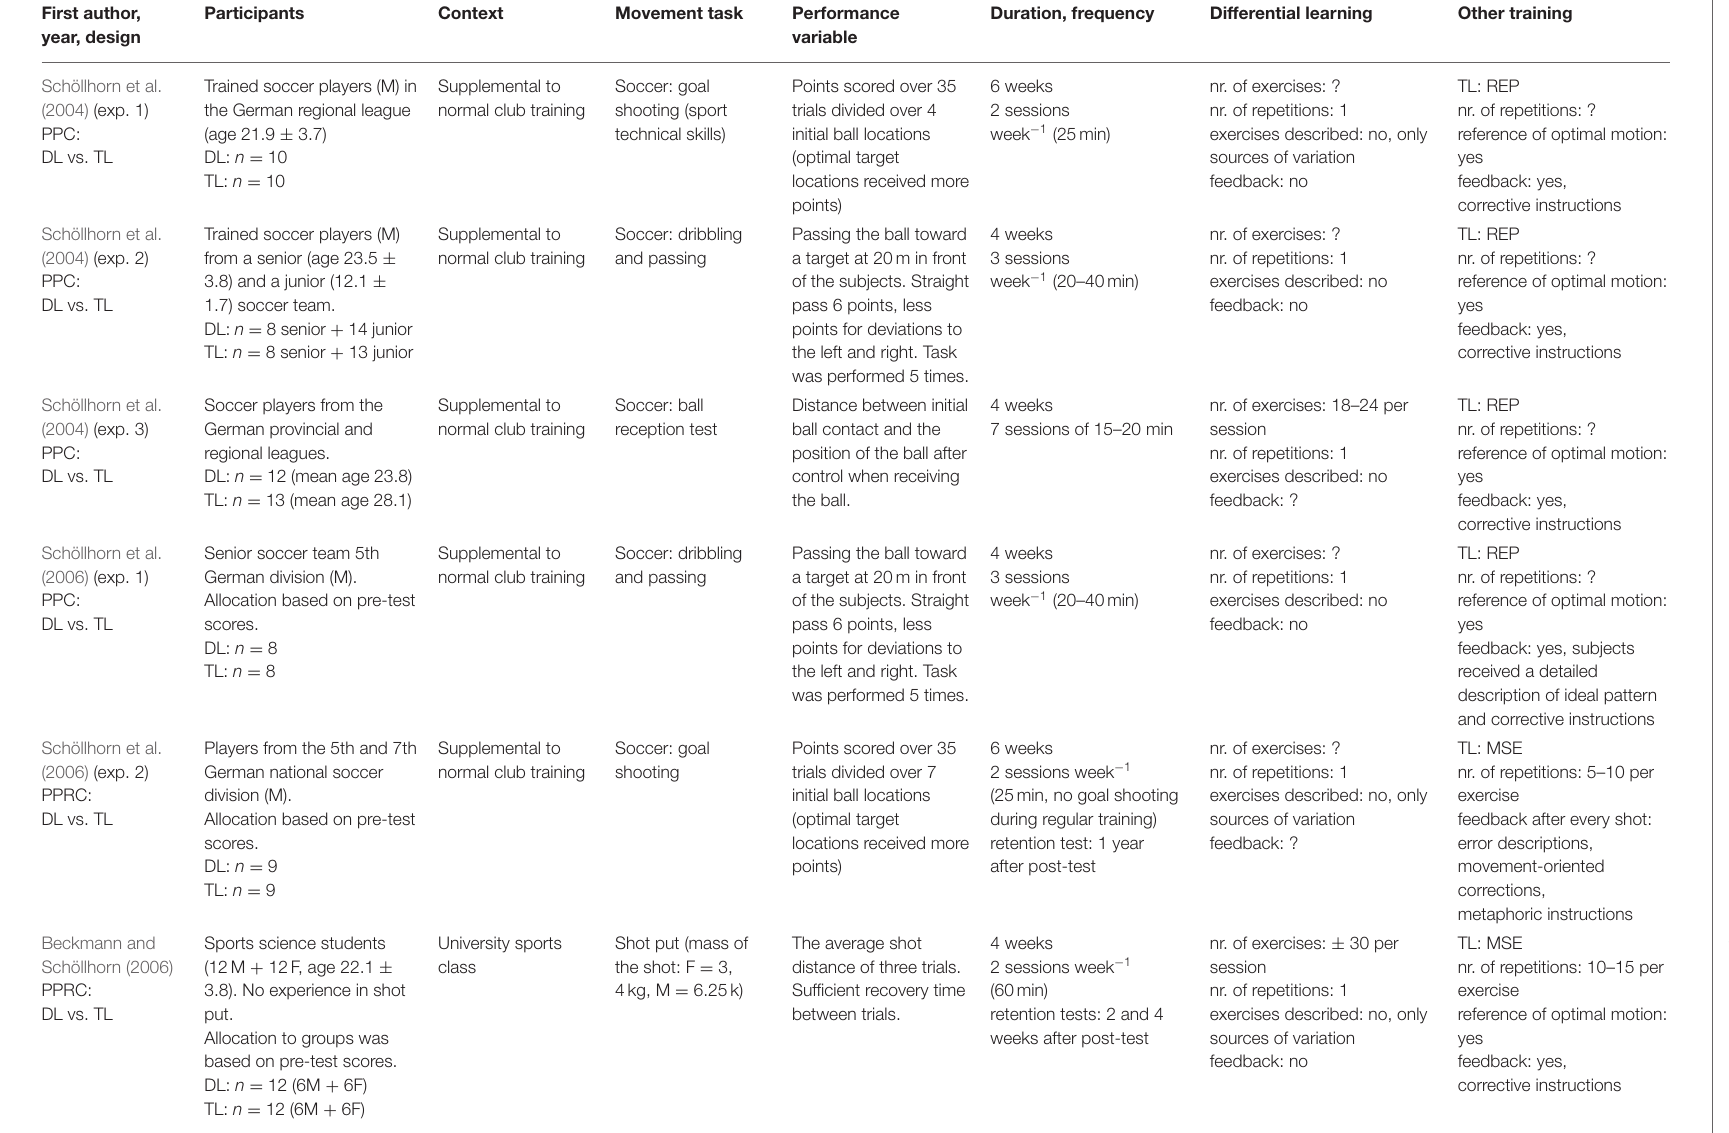
TABLE 1 | Design, participants, movement tasks, performance variables, and training interventions of studies included in the qualitative